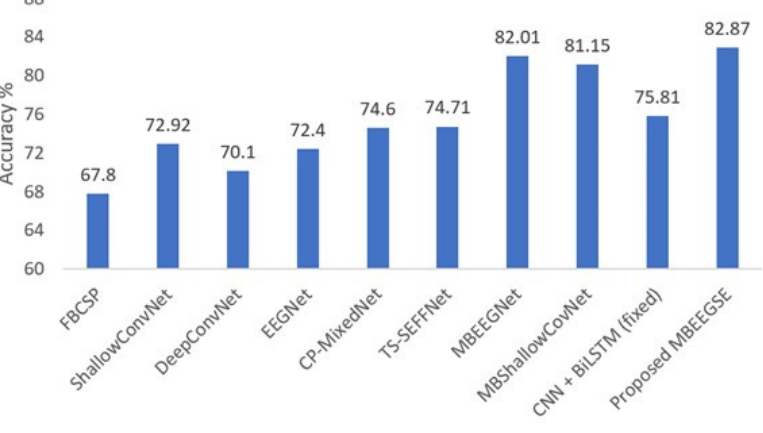
10 of 17 Table 2. The comparison summary of classification performance in proposed models. Datasets